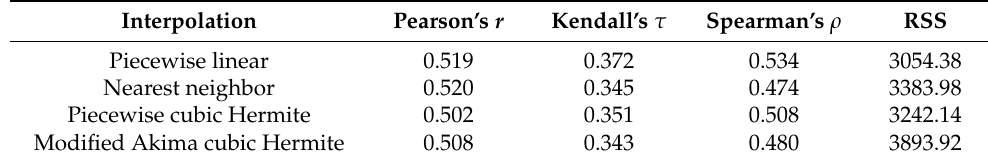
Table 7. Evaluation of models with 49 missing data.